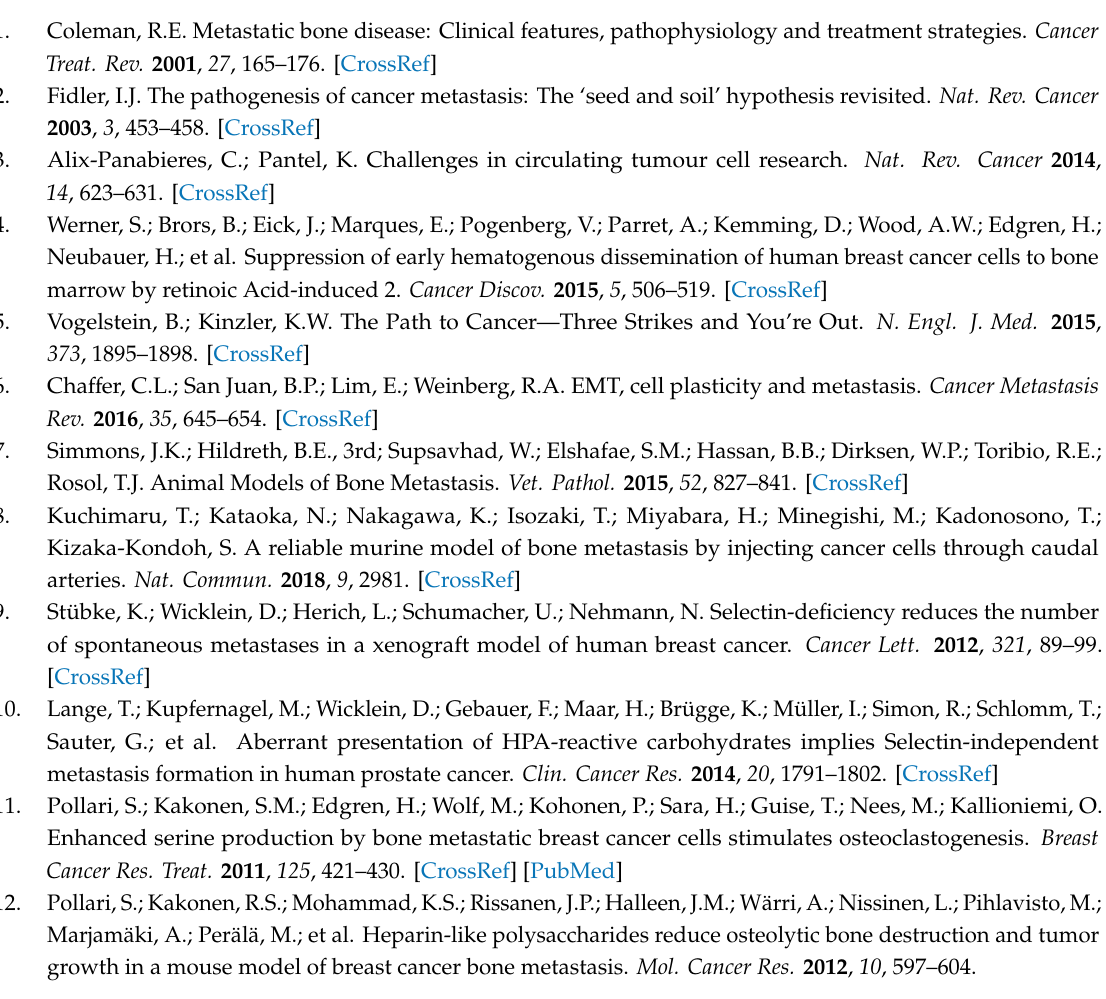
Figure S1: Cell surface protein levels of general or neuroblastoma-specific drivers of BM metastasis on primary tumor and corresponding bone metastasis